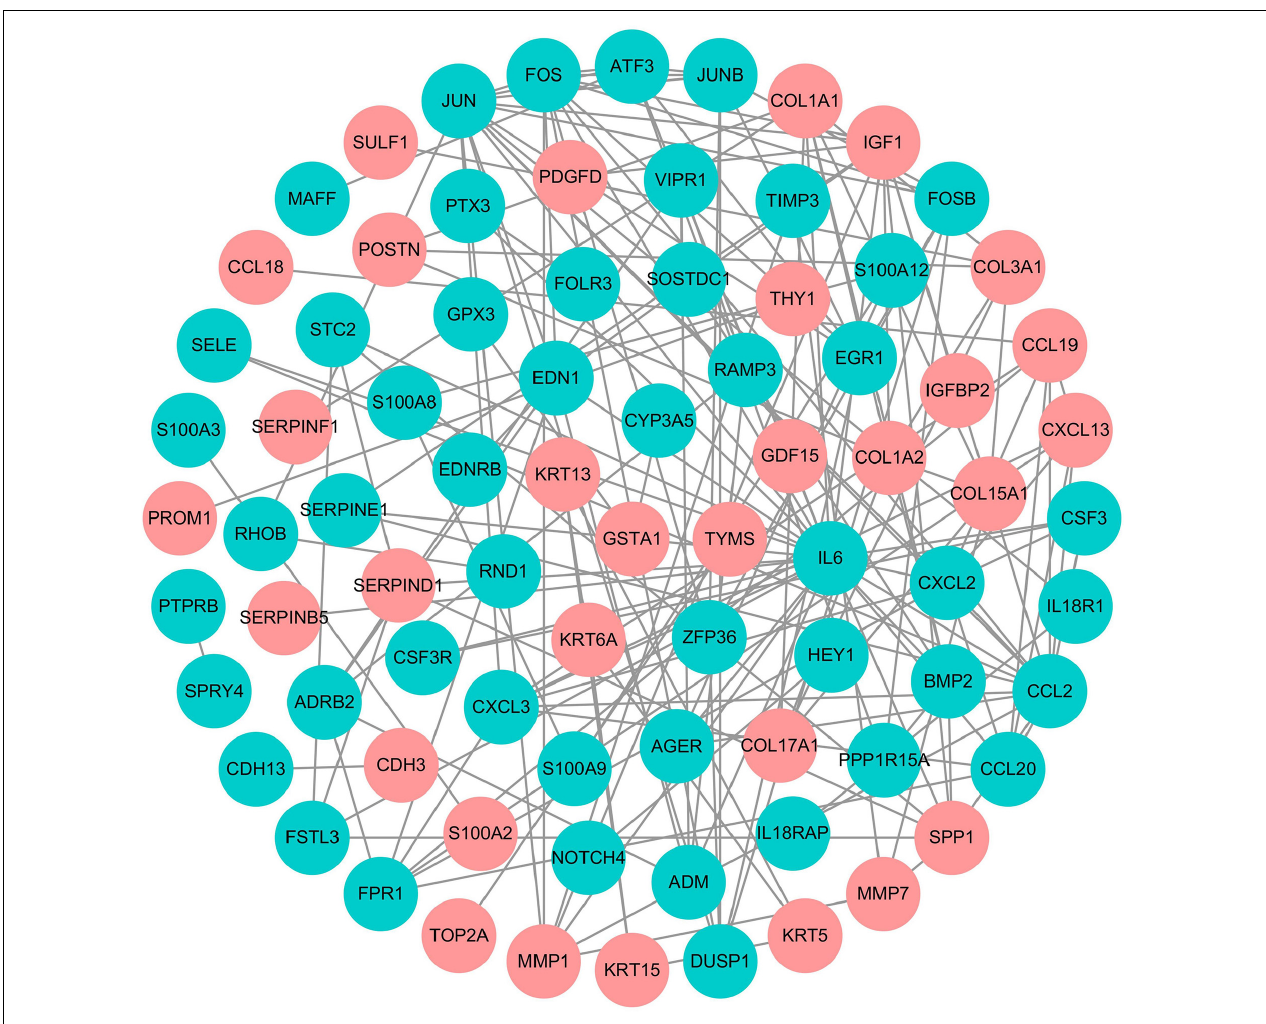
FIGURE 4 | The PPI network of DEMs in SSc-ILD. The red dots represent the upregulated genes, and the green dots represent the downregulated genes. PPI, protein-protein interaction; DEMs, differentially expressed messenger RNAs; SSc-ILD, systemic sclerosis-associated interstitial lung